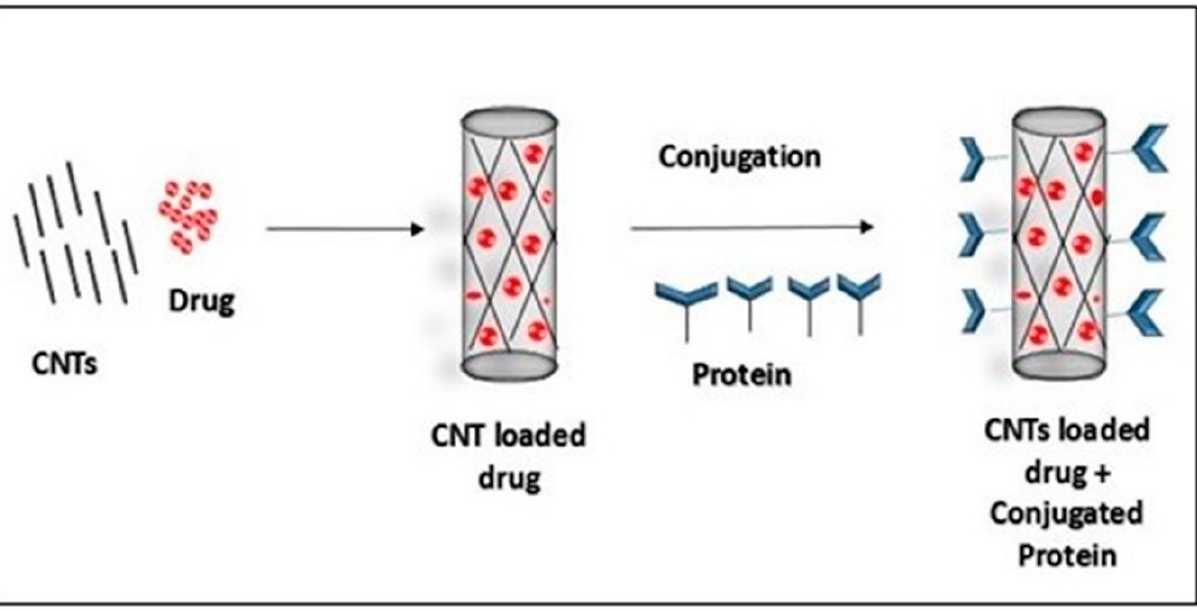
Figure 4. Loading of drug into CNTs and protein conjugation of CNTs.